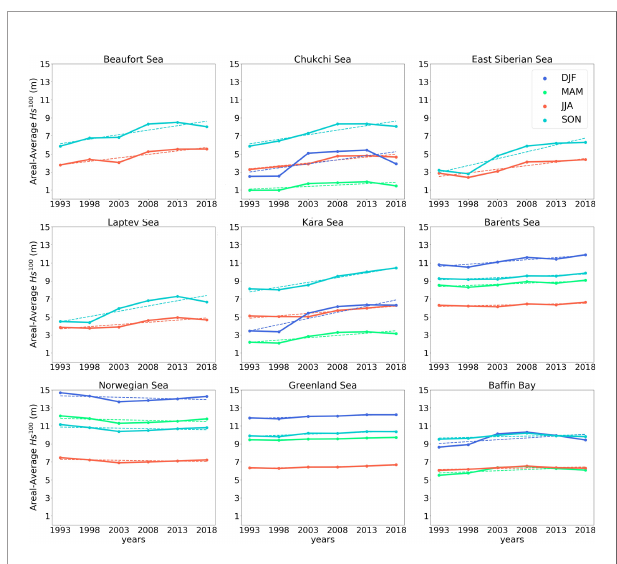
FIGURE 14 | Areal-averages of H 100 s in meters estimated by the seasonal TS-EVA approach for each sea in the Arctic Ocean for winter (blue), spring (light green), summer (red), and autumn (light